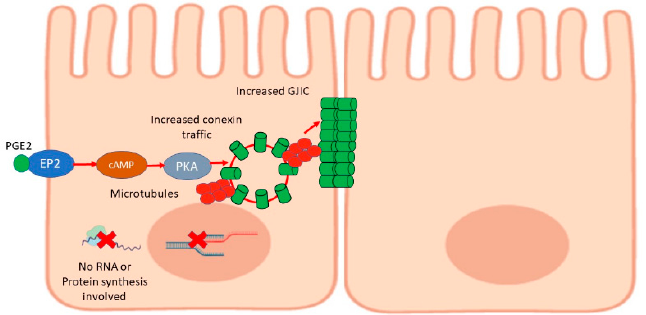
Figure 7. Scheme that summarizes the findings of this work: the binding of PGE2 to the EP2 receptor activates the cAMP and PKA pathway, having the effect of enhancing GJIC. No synthesis of mRNA or proteins is required; however, the effect depends on the vesicular traffic, suggesting that PGE2 stimulates the increase in the traffic of conexins already